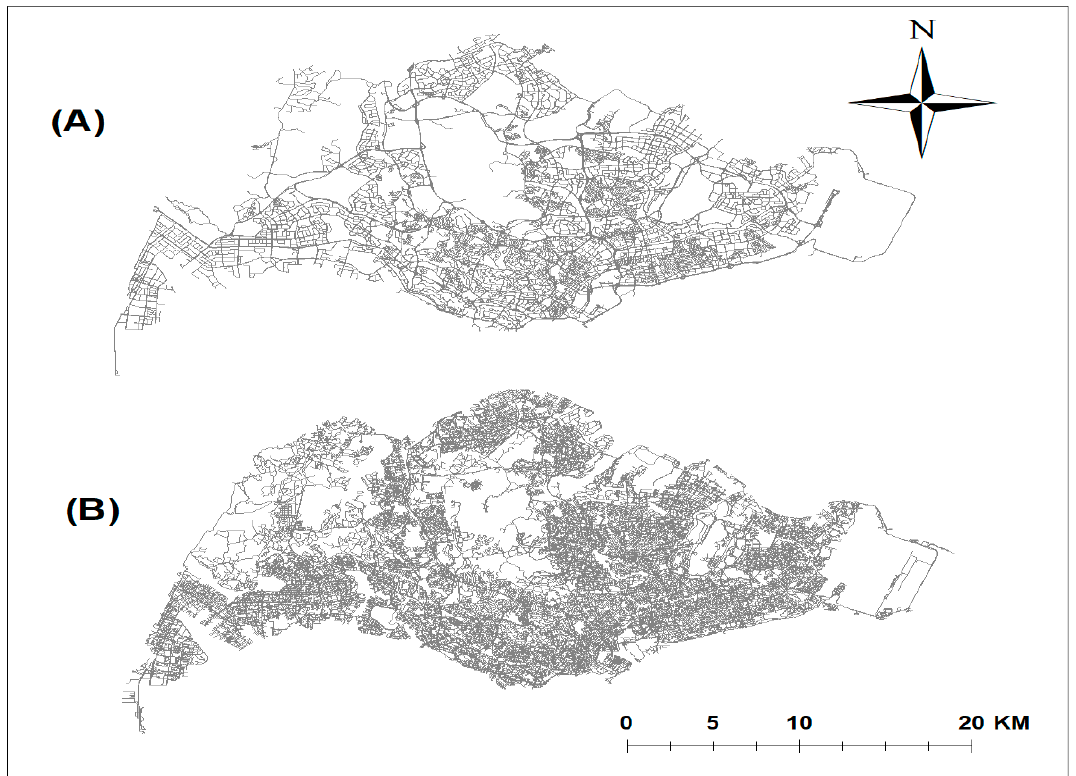
Figure 6. Comparison of drivable ( A ) and walkable street networks ( B ) in Singapore .